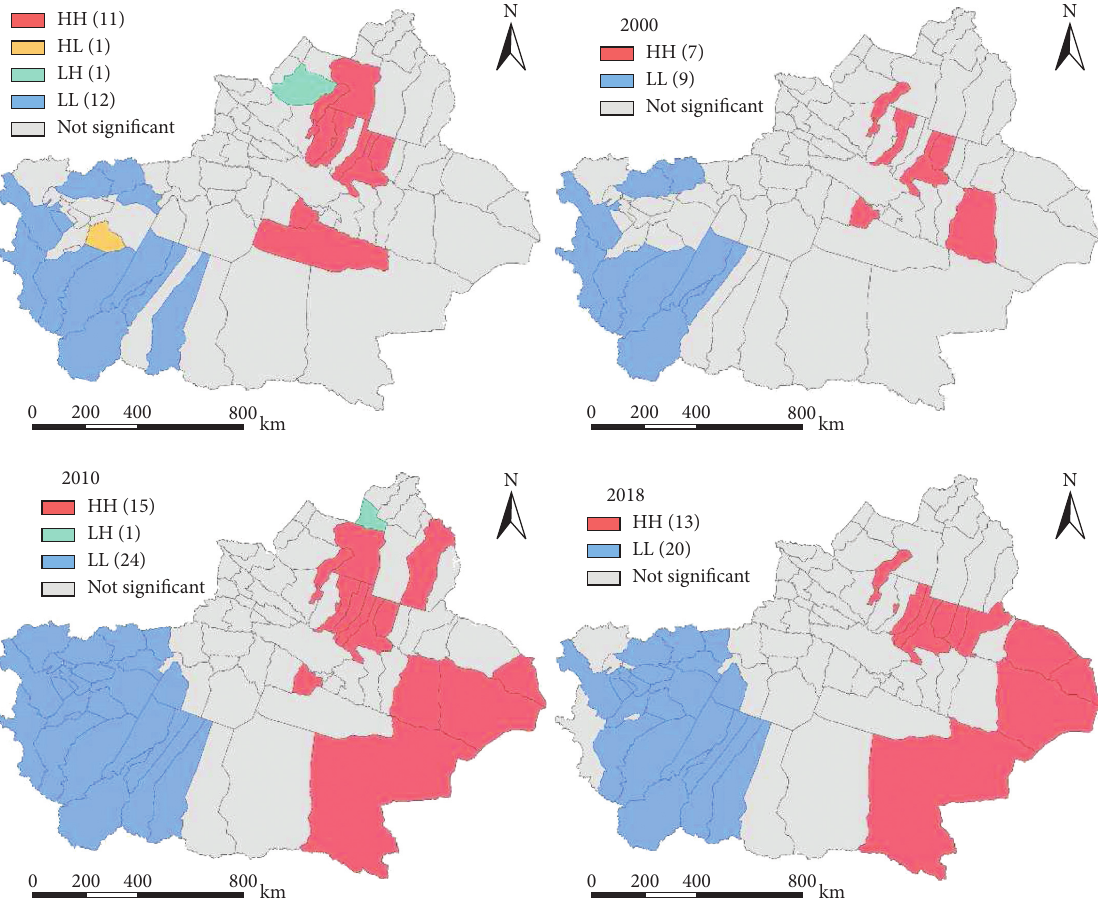
Figure 7: LISA map of spatial clustering for county-level GDPPC in Xinjiang, 1990–2018. HH: High-High cluster, LL: Low-Low cluster, HL: High-Low outlier, and LH: Low-High cluster outlier. Table 2: Change trend for county-level GDPPC in different regions, 1990–2018. Region